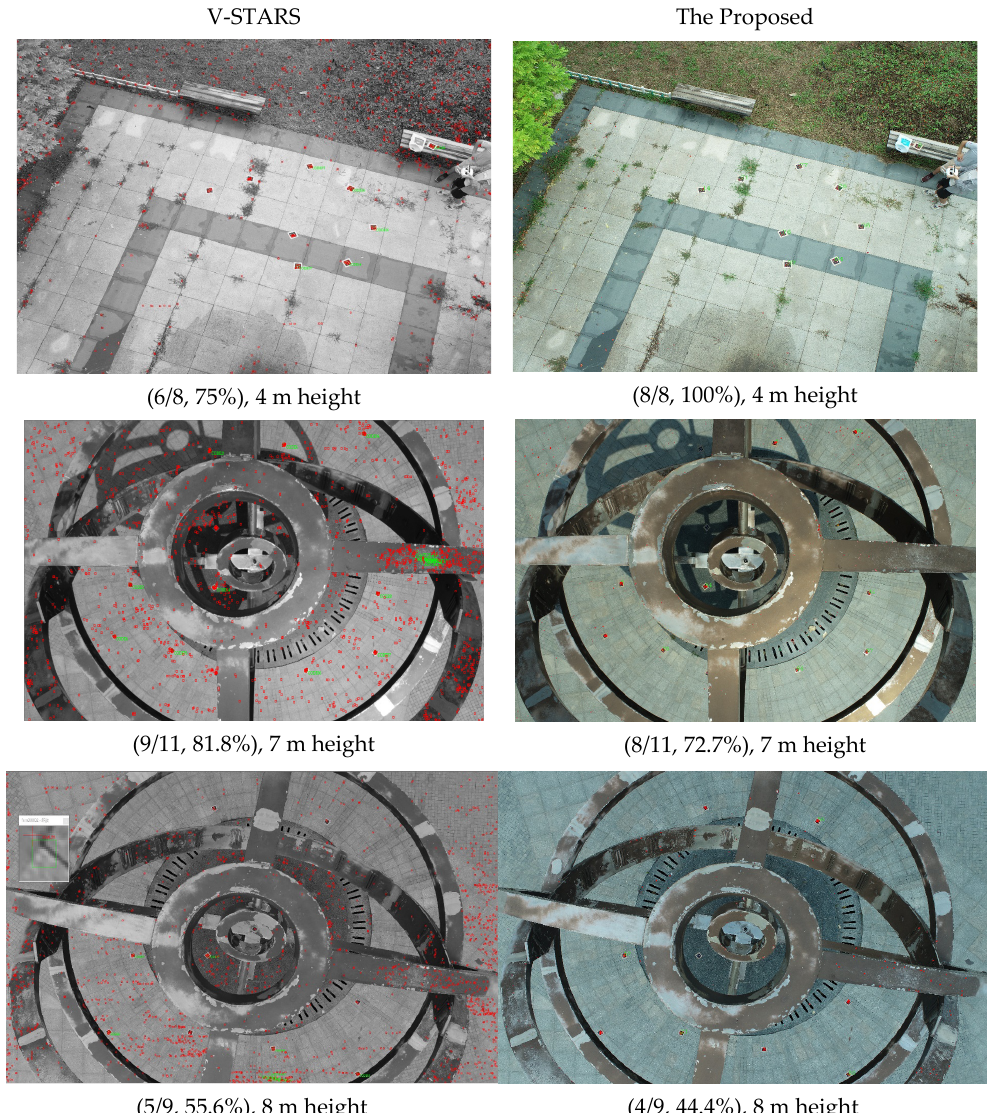
Figure 10. Experiment for UAV.